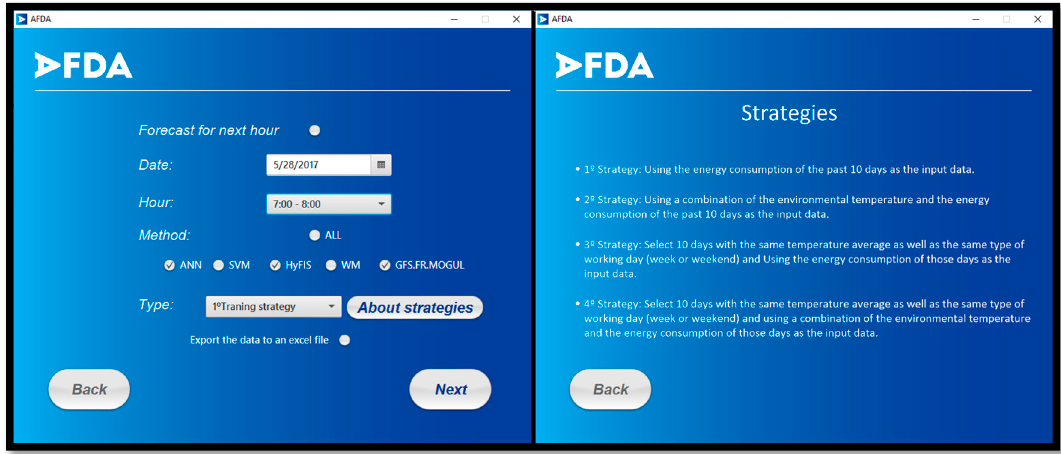
Figure 10. The Information picker and strategies explanation pages.